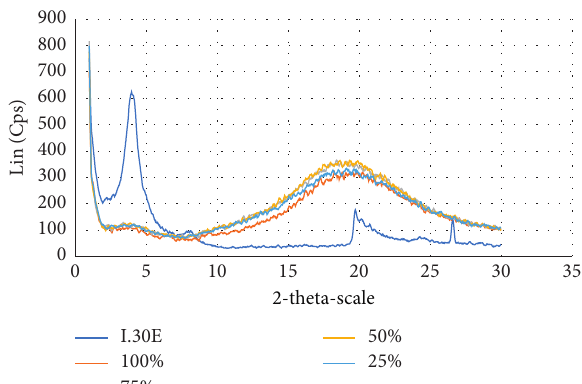
Figure 8: XRD diagram of epoxy Epikote 240/nanoclay I.30E nanocomposite material when ultrasonically stirring with different capacities.